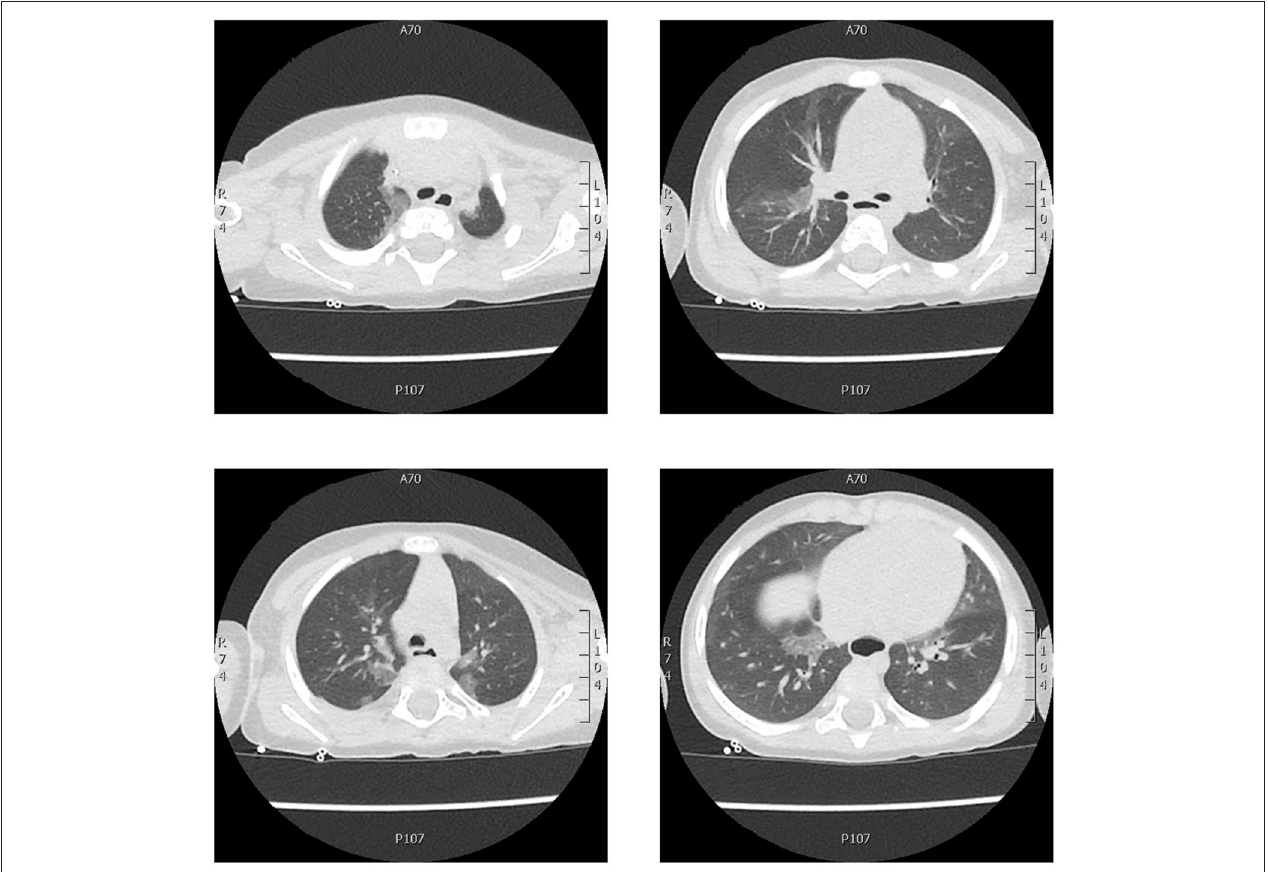
FIGURE 1 | Chest CT axial scan showing areas of central and peripheral ground-glass opacity extending from the apex to the base of both lungs with no pleural effusion. The estimated total lung involvement was